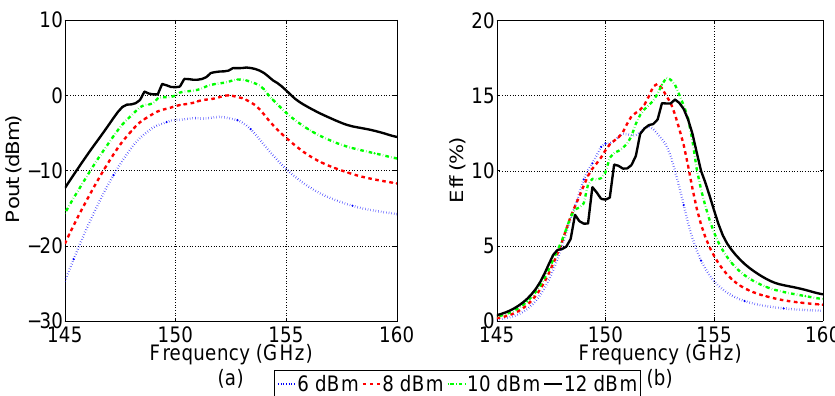
Figure 6. Predicted response of the frequency doubler for different IN input power levels: ( a ) Output power and ( b ) Efficiency.